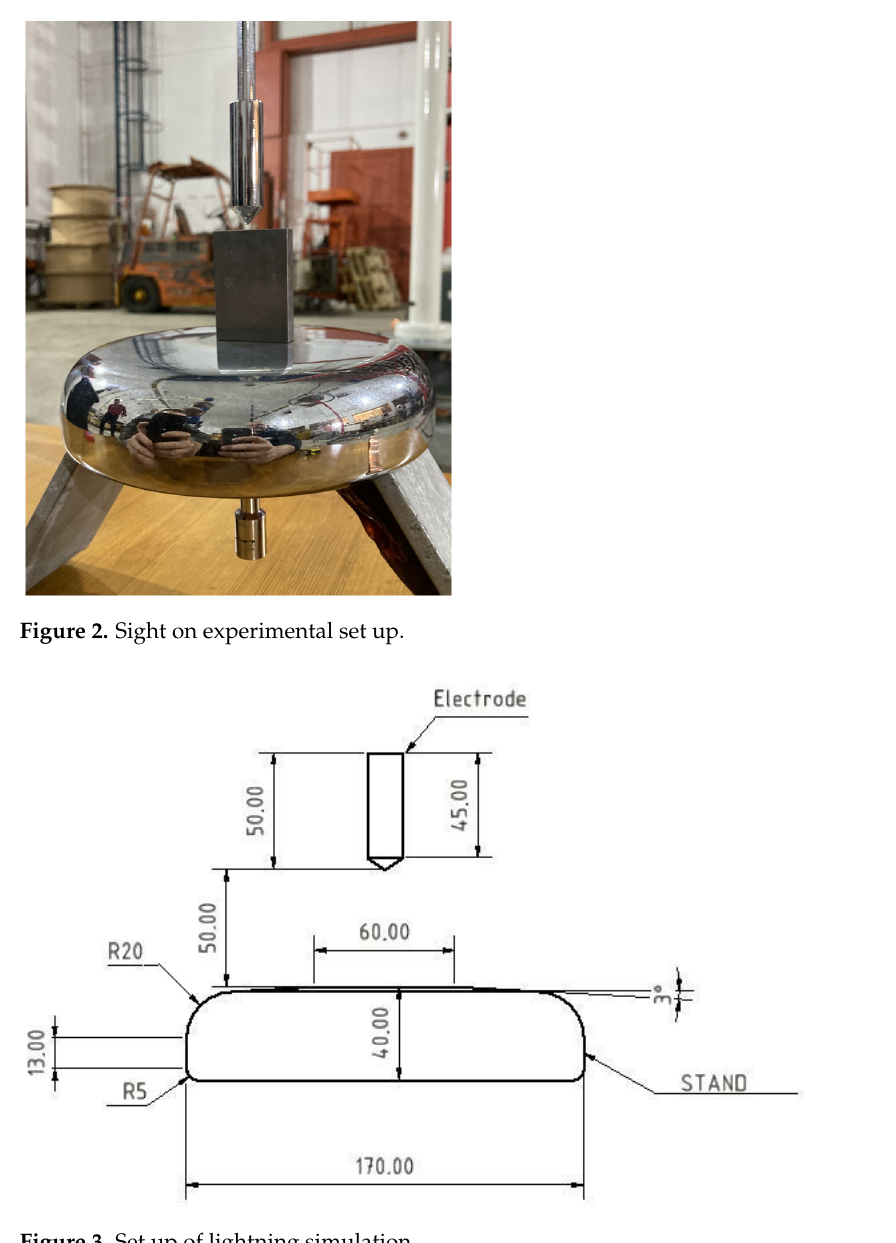
Figure 3. Set up of lightning simulation.